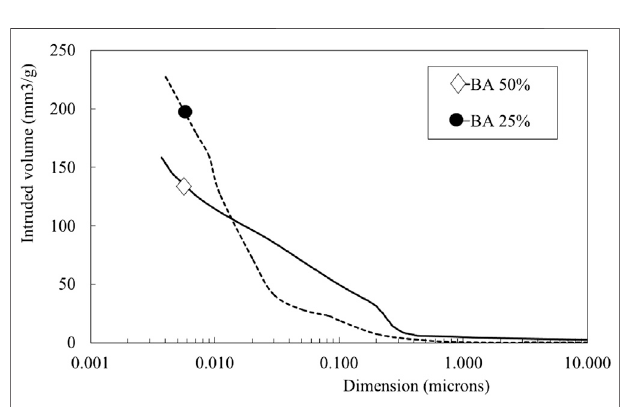
FIGURE 3 | Cumulative intruded volume in the plain